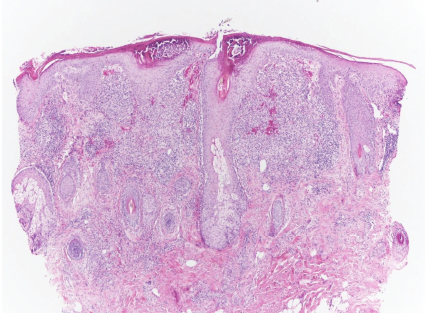
Figure 3: Hematoxylin-eosin biopsy specimen showing dense folliculocentric lymphohistiocytic infiltrate with a pustule and a demodex mite (40x).